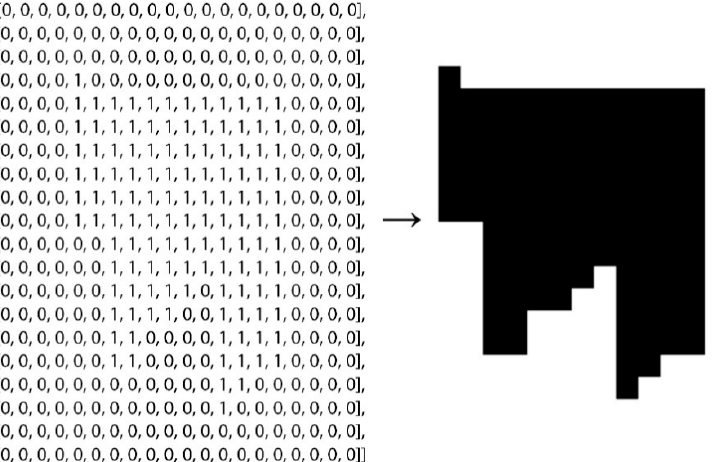
Figure 6. Forming the shape of the building from the array. Cells that are labeled 1 are presented as black squares and cells that are labeled 0 are white squares.